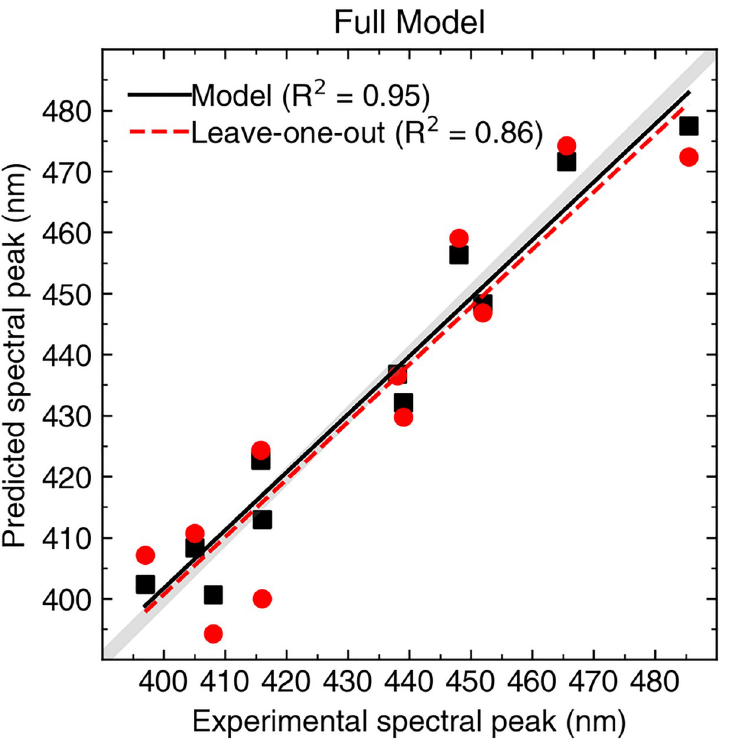
Fig 5. Experimental spectral peaks of absorbance ( λ max ) compared to predicted λ max values by the full model Eq 1 outlined in the main text for all 11 Sws2 photopigments analyzed. Gray lines indicate a perfect (100%) correlation. Solid black lines and black symbols represent the linear relationships between model-predicted and the experimental λ max values, whereas dashed red lines and red symbols show linear relationships between “leave-one-out” predictions and experimental λ max values. Corresponding correlation coefficients for both approaches are indicated.